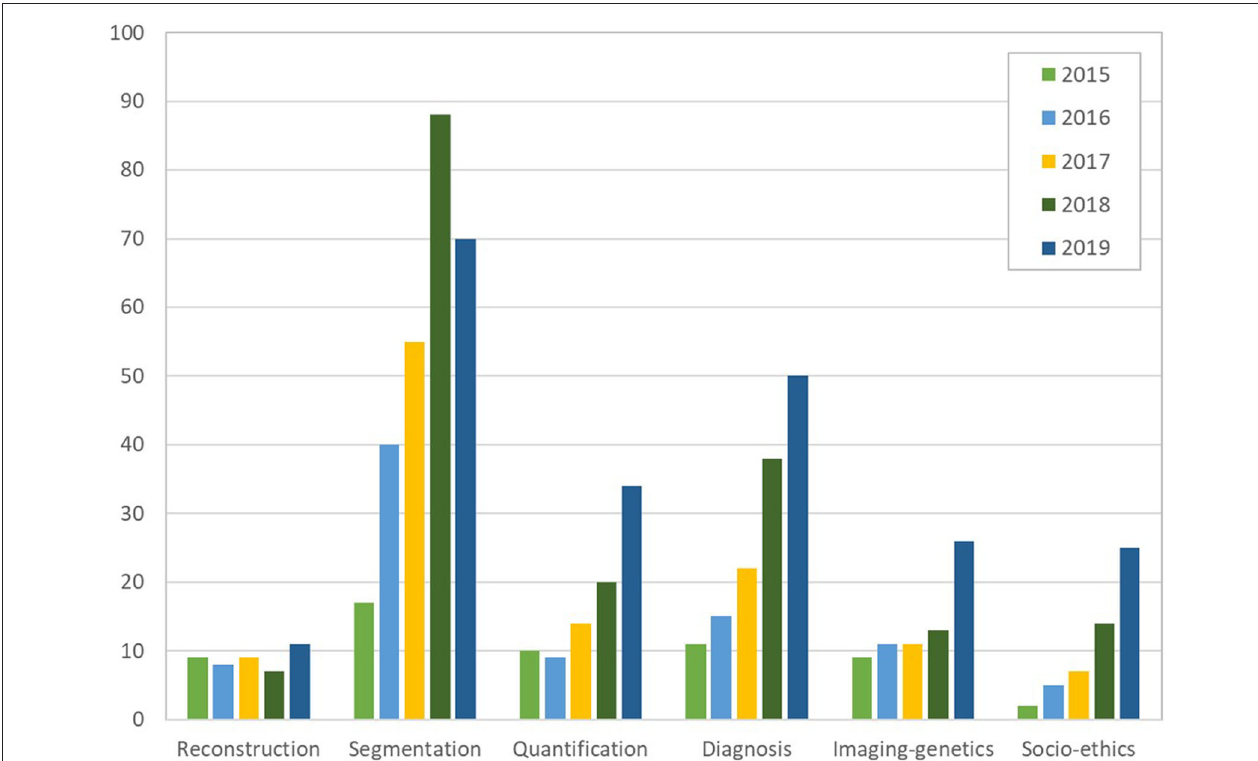
FIGURE 2 | Number of papers reviewed in the six categories of cardiac imaging tasks in the last 5 years (2015 to 2019), showing an increase in the research output continuously and for all tasks, except for segmentation which decreased between 2018 and 2019 (over 550 papers reviewed in total). The subfigures are taken from the different papers in this special